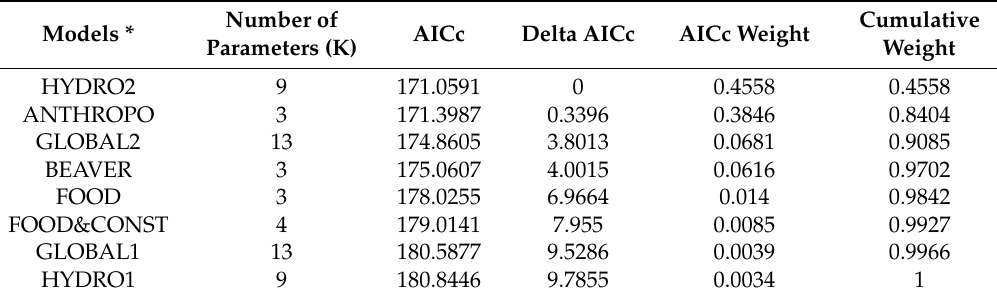
Table 3. Results of model selection using the Akaike information criterion